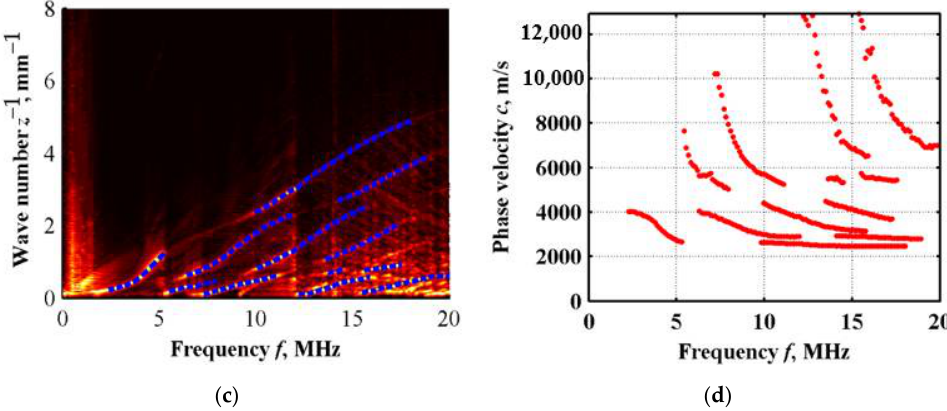
Figure 9. Defocusing experiment simulation results. ( a ) Time domain signal waveform at different defocusing positions; ( b ) frequency domain diagram after time domain Fourier transform; ( c ) frequency peak tracing after spatial Fourier transform; ( d ) Lamb wave dispersion curves.